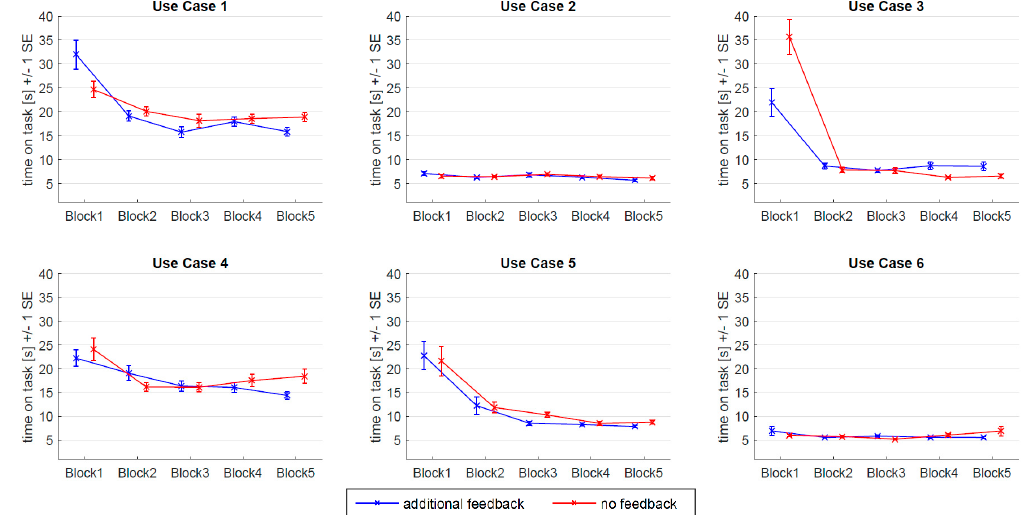
Figure 2. Means and standard errors for time on task in the 6 use cases by time of measurement (x- axis) and feedback condition (blue: additional feedback; red: no